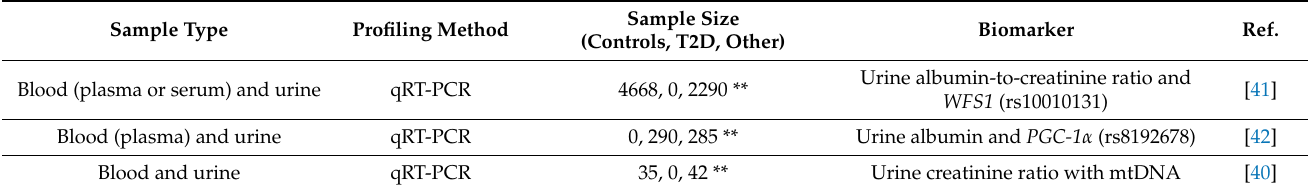
Table 3. Genomics biomarkers from urine samples for